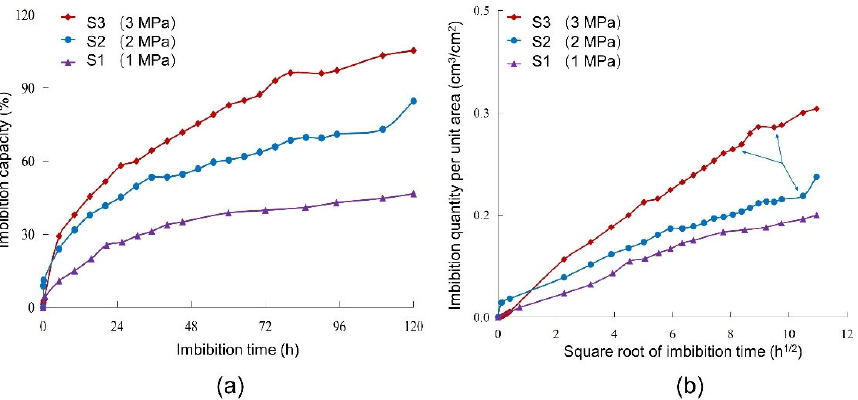
Figure 9. Comparison of forcible imbibition capacities and imbibition quantities of 3 samples under different fluid pressures.